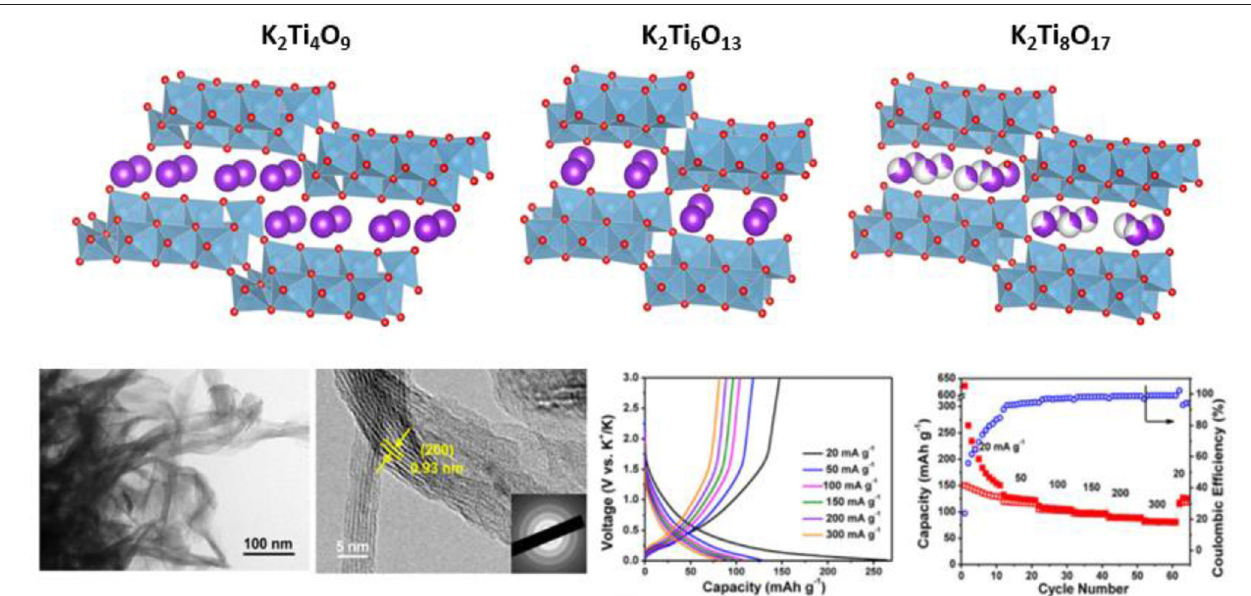
FIGURE 4 | Top, crystal structures of K 2 Ti 4 O 9 , K 2 Ti 6 O 13 , and K 2 Ti 8 O 17 (from left to right) showing the layered organization with triplet of edge-shared TiO 6 octahedra chains and potassium ions in the interslab spaces. Bottom, TEM and HRTEM of Ti 3 C 2 -derived K 2 Ti 4 O 9 nanoribbons and corresponding electrochemical performance. Adapted with permission from Dong et al. (2017) Copyright (2017) American Chemical